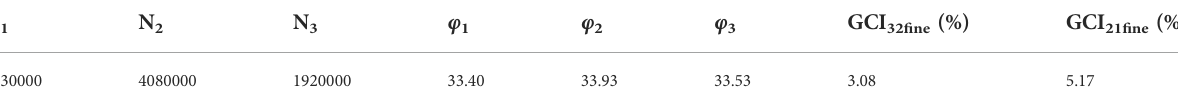
TABLE 3 Grid independence check.